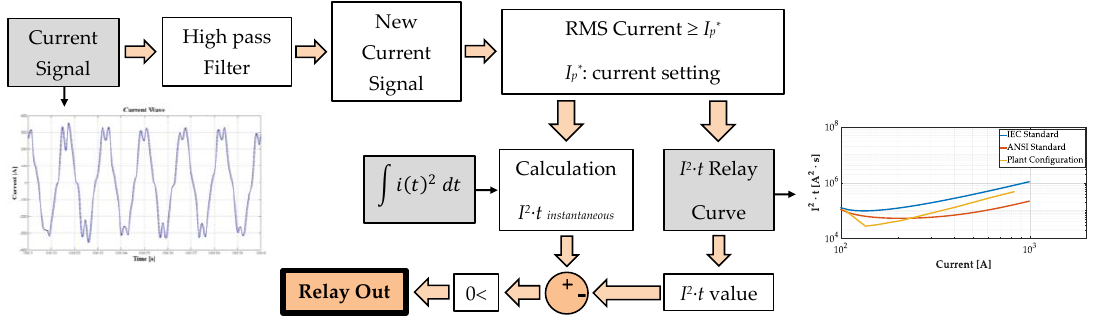
Figure 9. Trip curve used in the model. In summary, only the current downstream from the PCC of the filters is required to launch the complete single-phase plant model. The current of the case study corresponds to that in Figure 6.